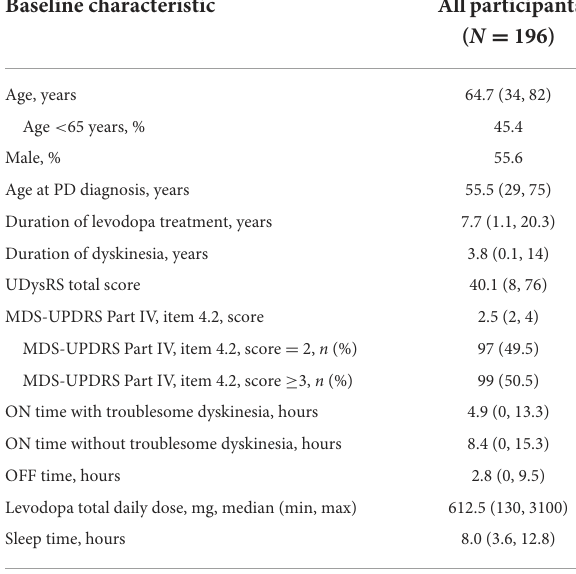
TABLE 1 Baseline demographics and Parkinson’s disease characteristics. Baseline